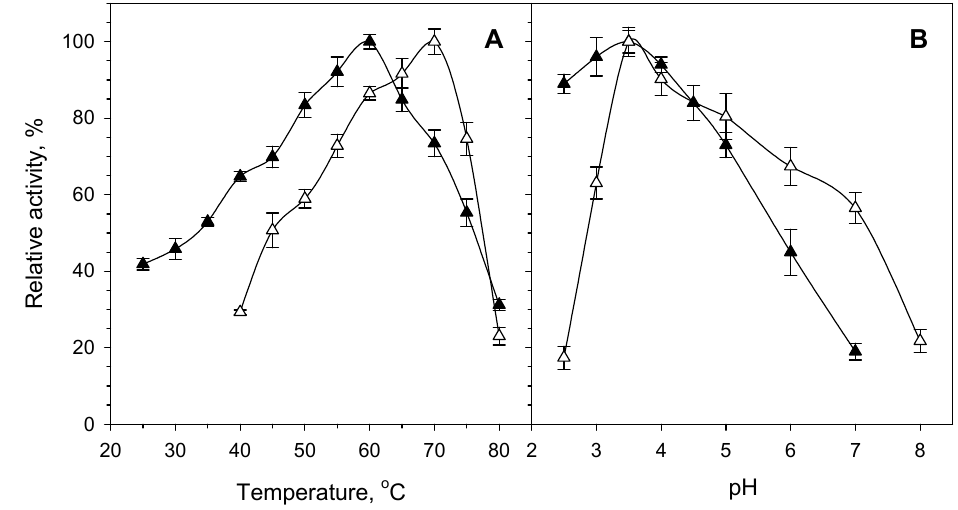
Figure 2. Effect of temperature (( A ) determined at pH 4) and pH (( B ) determined at 50 °C) on the activity of the purified PvXyn11A ( ▲ ) and PvXyd3A ( ) of B. spectabilis ATHUM 8891.